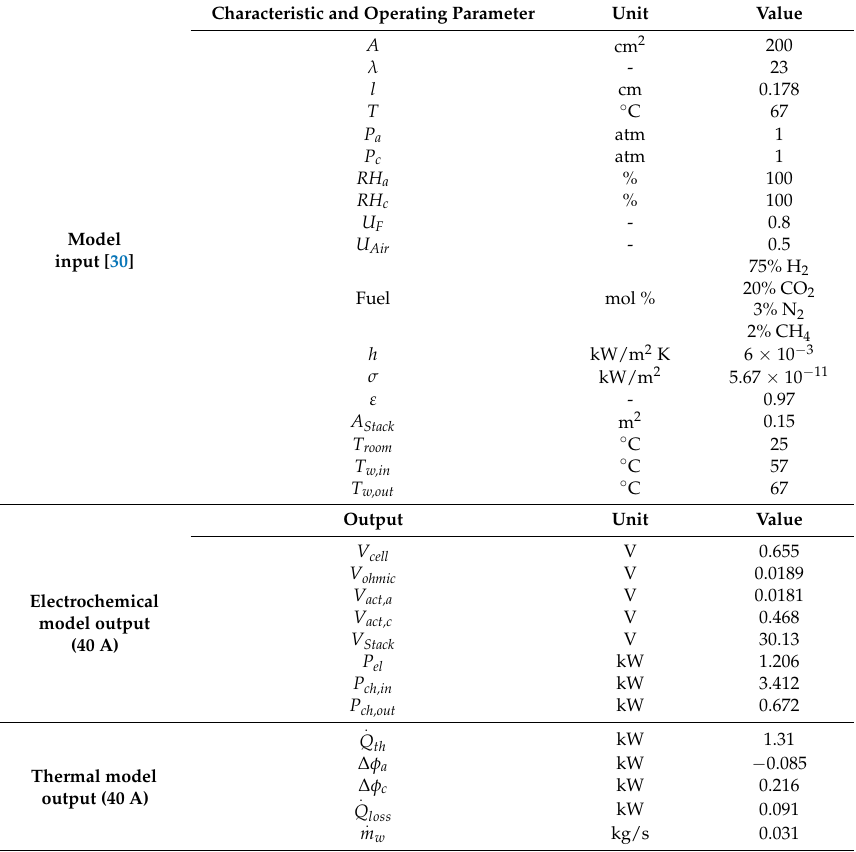
Table 3. Input and output to/from the model